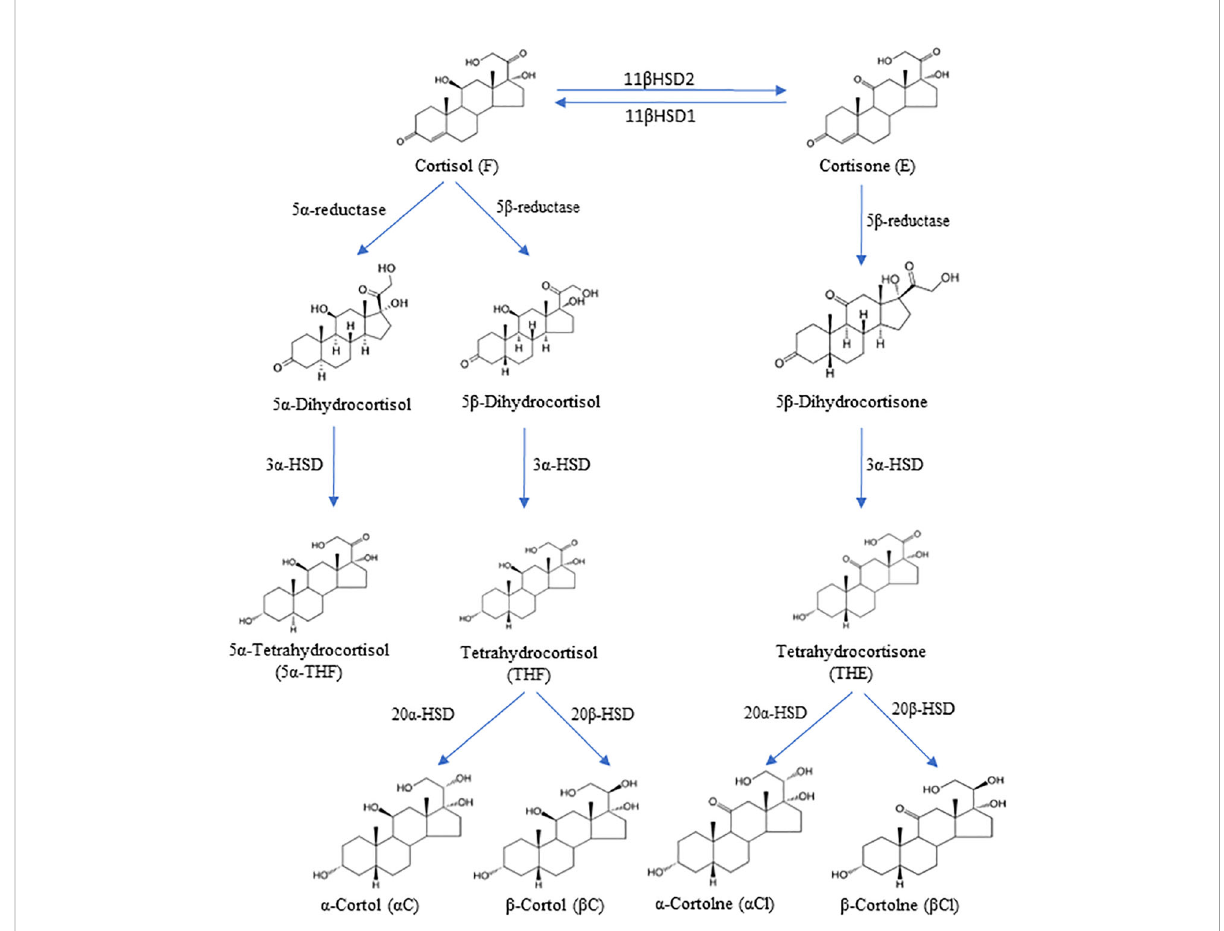
FIGURE 1 The degradation pathway of cortisol and cortisone and their metabolites. 11 b -hydroxysteroid dehydrogenase type 1 (11 b HSD1), 11 b -hydroxysteroid dehydrogenase type 2 (11 b HSD2), 3 a -hydroxysteroid dehydrogenase ( 3 a HSD), 20 a -hydroxysteroid dehydrogenase (20 a HSD), 20 b -hydroxysteroid dehydrogenase (20 b